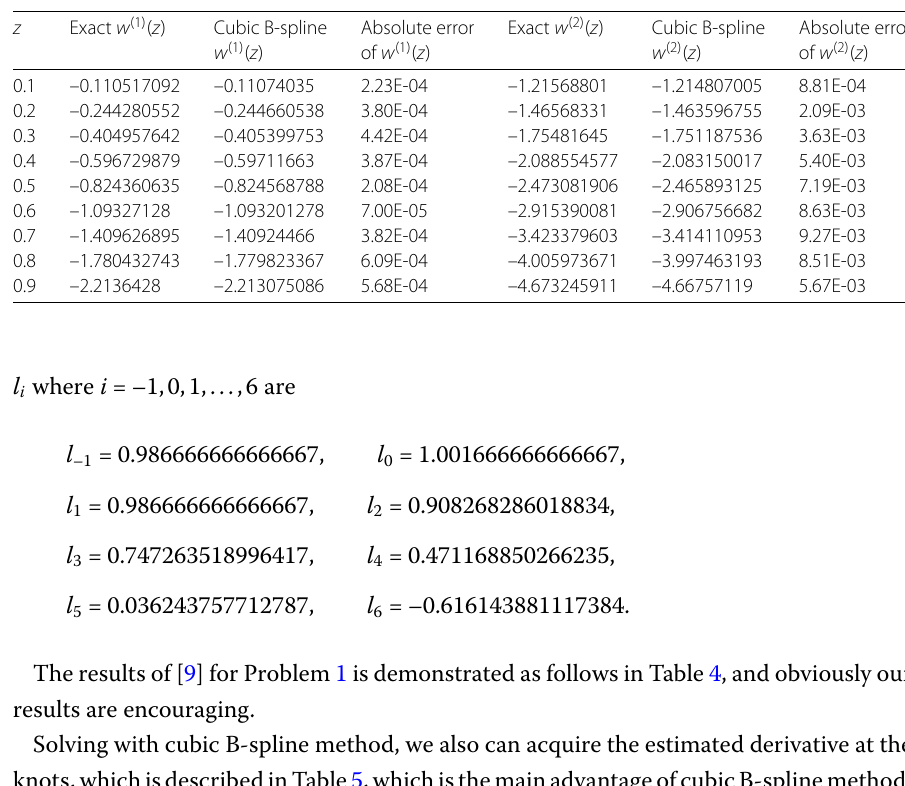
Table 5 Estimated derivative at the knots for Problem